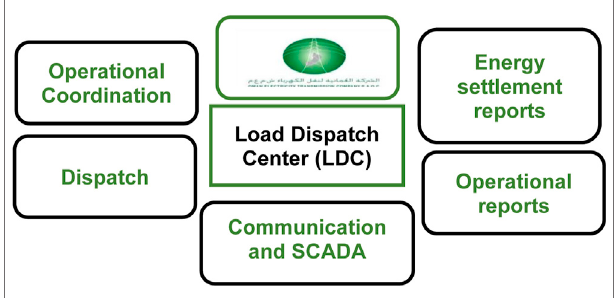
FIGURE 8 | Tasks of the load dispatch center in the Oman power grid.